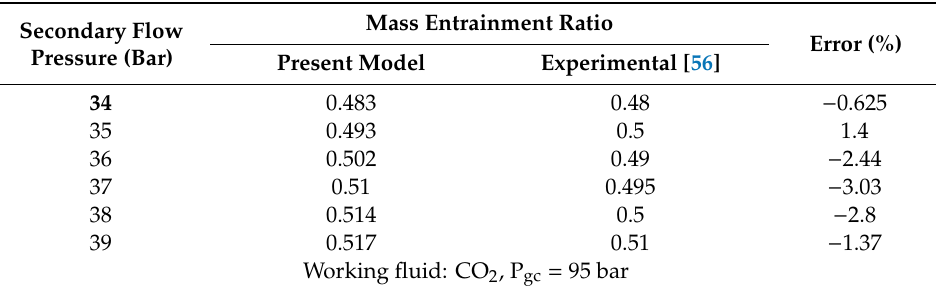
Table 5. Simulation results validation with the published data.